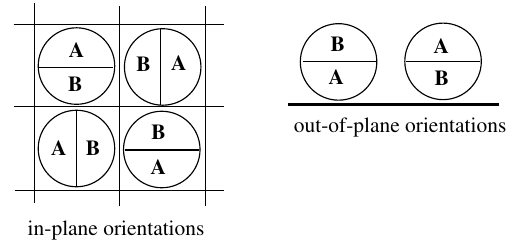
Figure 1. Six allowed orientations of particles. The left part shows the top view of the four in-plane orientations, while the right part shows the side view of the two out-of-plane orientations.